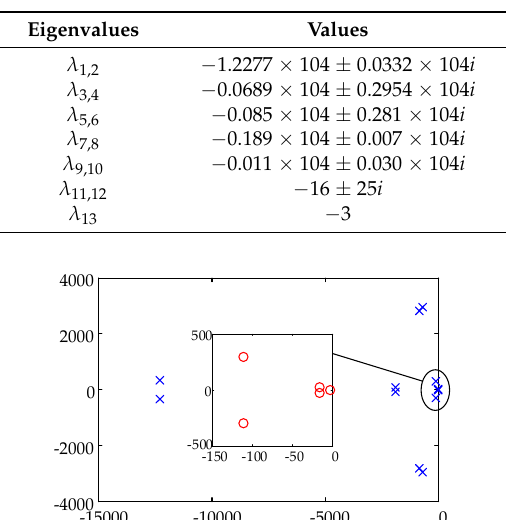
Table A1. Eigenvalues of IIDG detailed model.